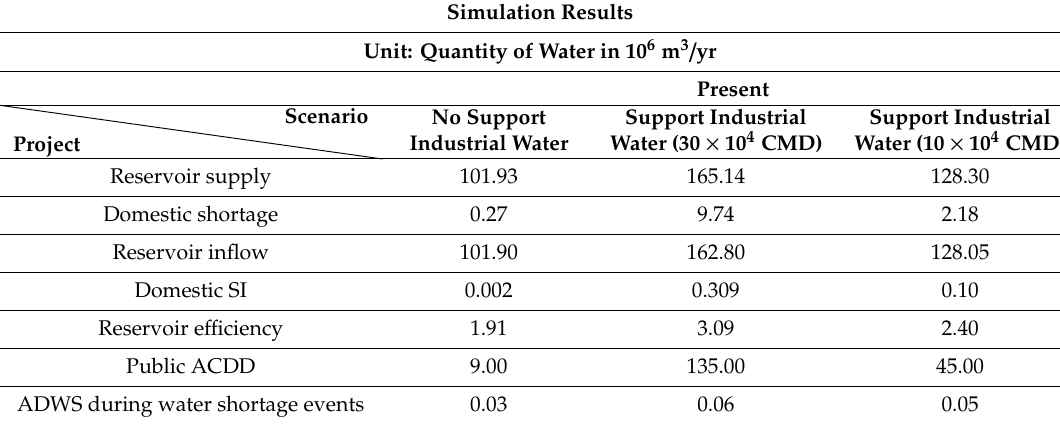
Table 6. Indices of the water supply for present.